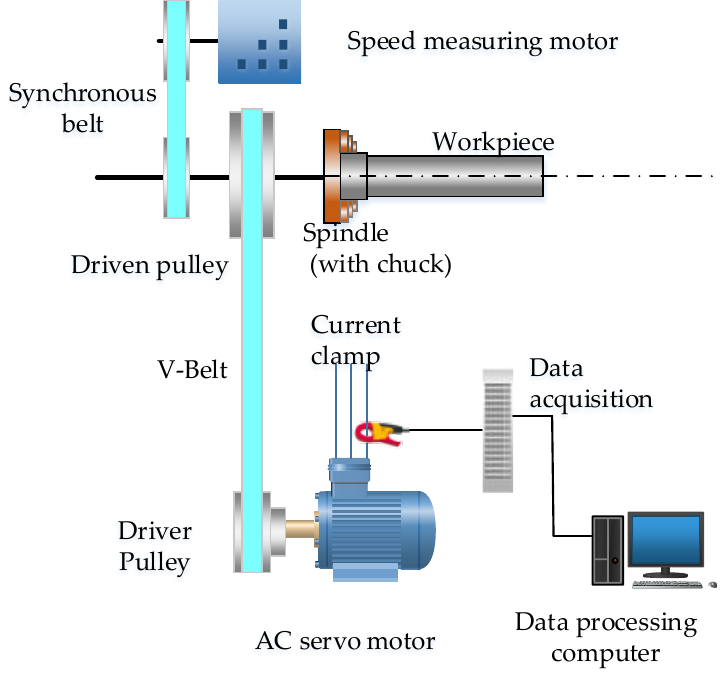
Figure 14. Experimental scheme.